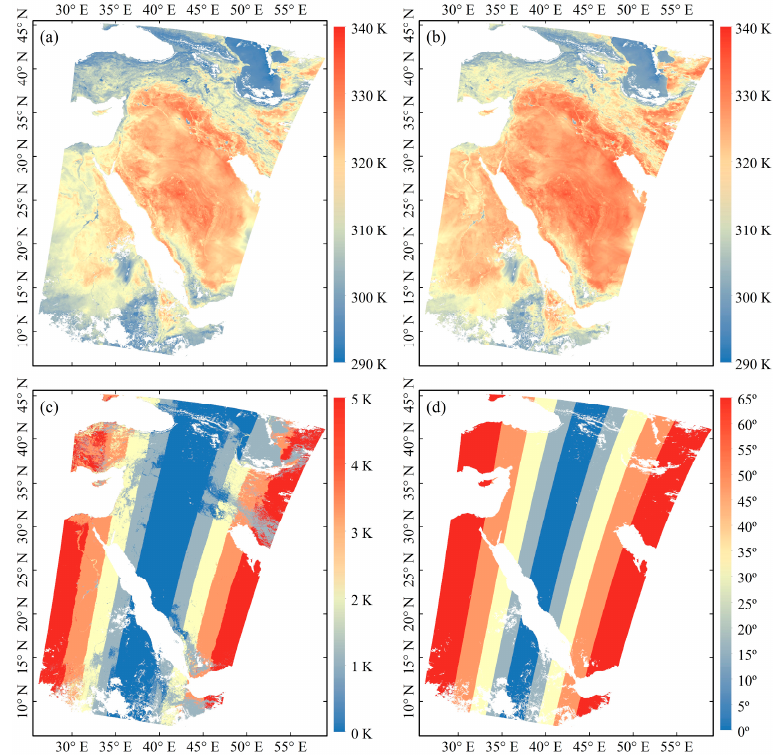
Figure 9. MODIS LST before ( a ) and after ( b ) angular correction, their differences ( c ), and viewing zenith angles ( d ) at 08:00 on 25 June 2011 (UTC).